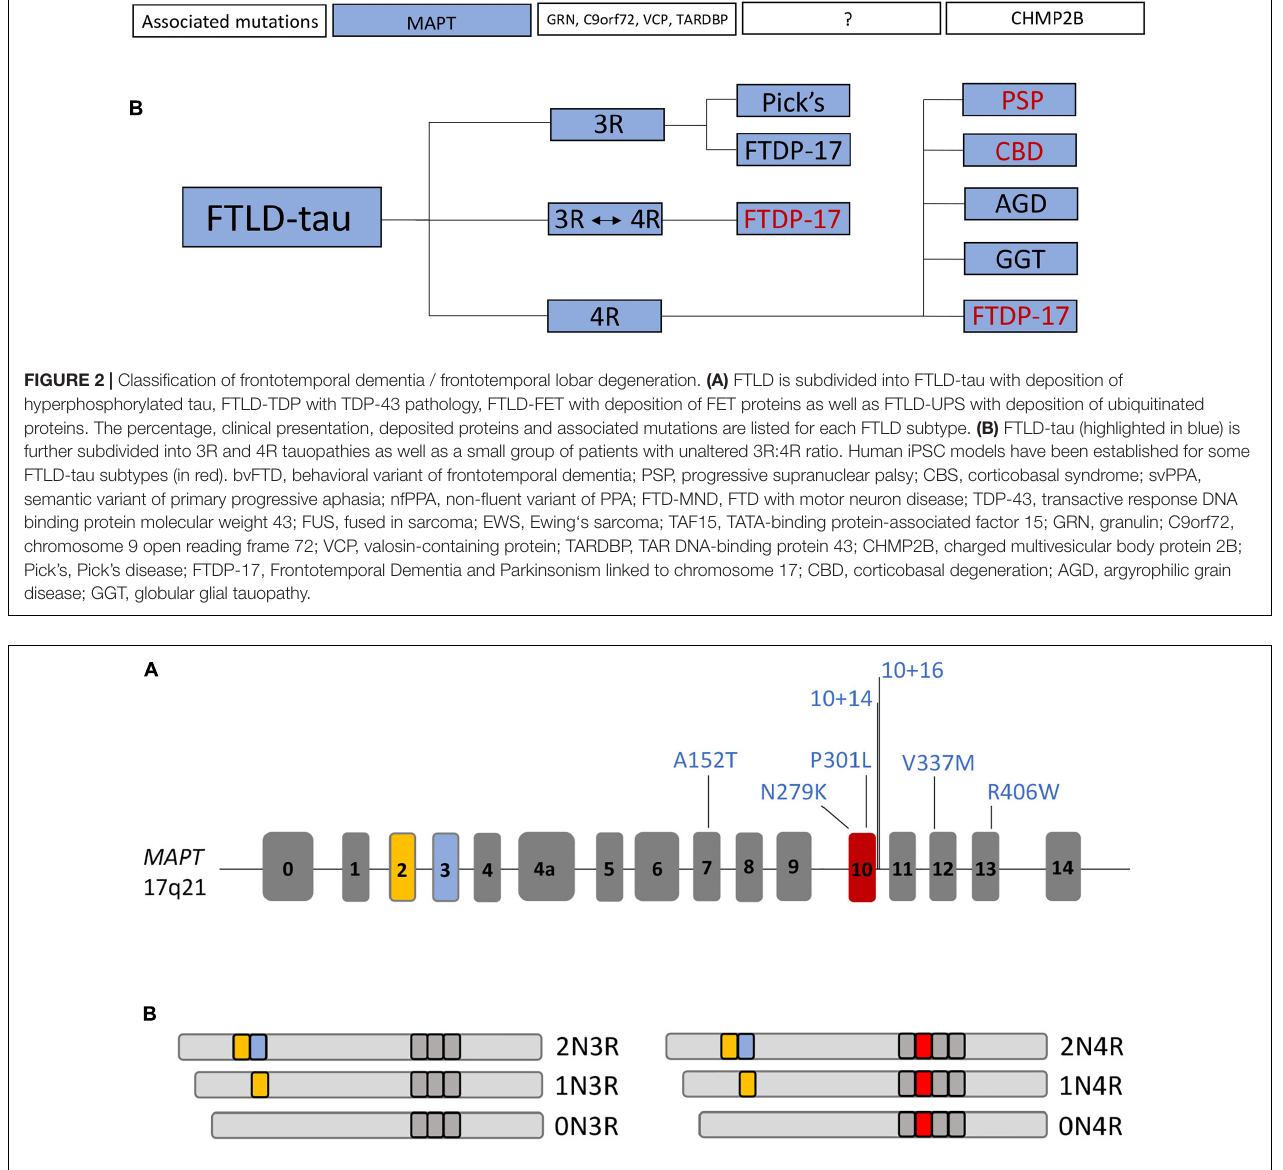
FIGURE 3 | The MAPT gene and its different splice isoforms. (A) Drawing of the MAPT gene composed of 16 exons. MAPT mutations, for which human iPSC models with disease phenotypes have been described, are highlighted. (B) MAPT is spliced into 6 different isoforms in the adult human brain, 0N3R, 1N3R, 2N3R, 0N4R, 1N4R, or 2N4R tau, with presence or absence of exons 2, 3, and 10 in